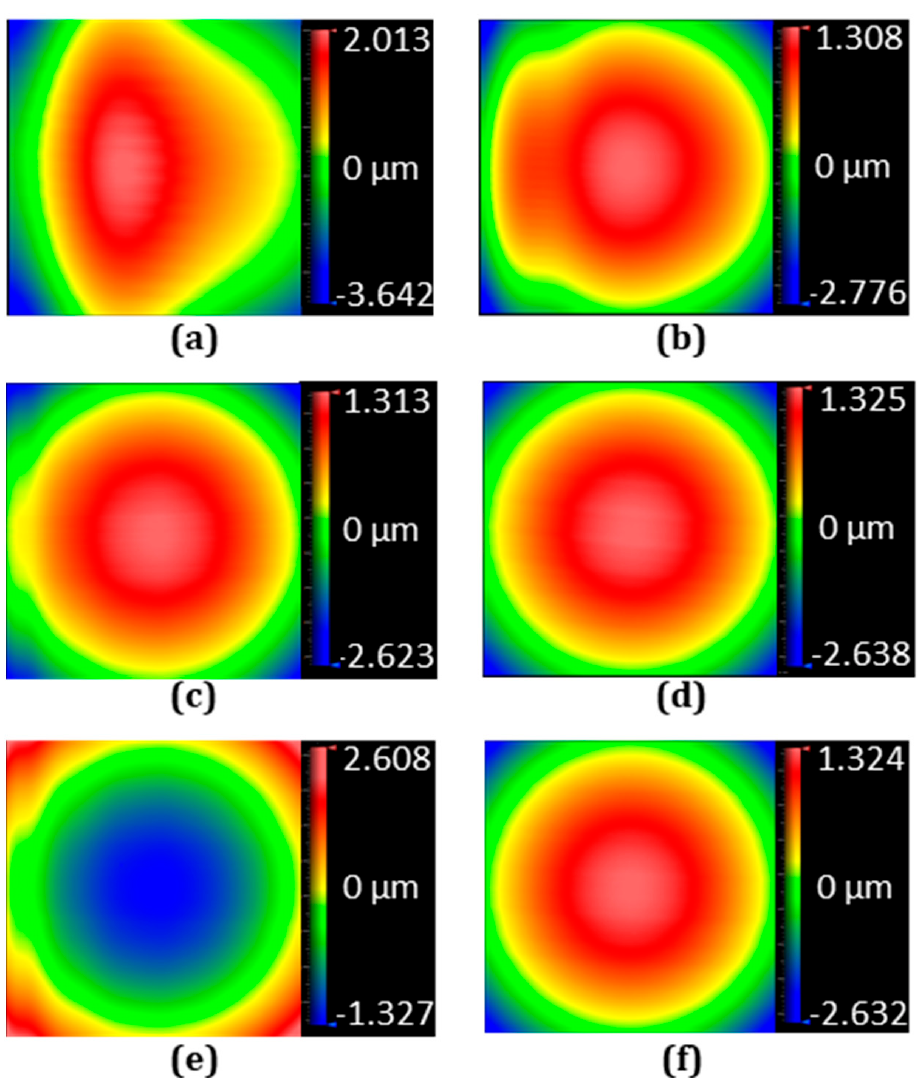
Figure 9. Measured surface shape of the 5th lenslet indicated in Figure 2 under different cutting parameters. Convex lenslet arrays with ( a ) 0.25 ◦ constant-angle sampling and 0.001 s inverse time feed, ( b ) 0.25 ◦ constant-angle sampling and 0.004 s inverse time feed, ( c ) 2.5 µ m constant-arc sampling and 0.001 s inverse time feed, ( d ) 2.5 µ m constant-arc sampling and 0.004 s inverse time feed, ( e ) concave lenslet array with 2.5 µ m constant-arc sampling and 0.001 s inverse time feed, and ( f ) convex lens array with 2.5 µ m constant-arc sampling in the outer region and 0.25 ◦ constant-angle sampling in the center region and 0.004 s inverse time feed. The measurement is performed with a Zygo Newview 8300 optical surface profilometer.